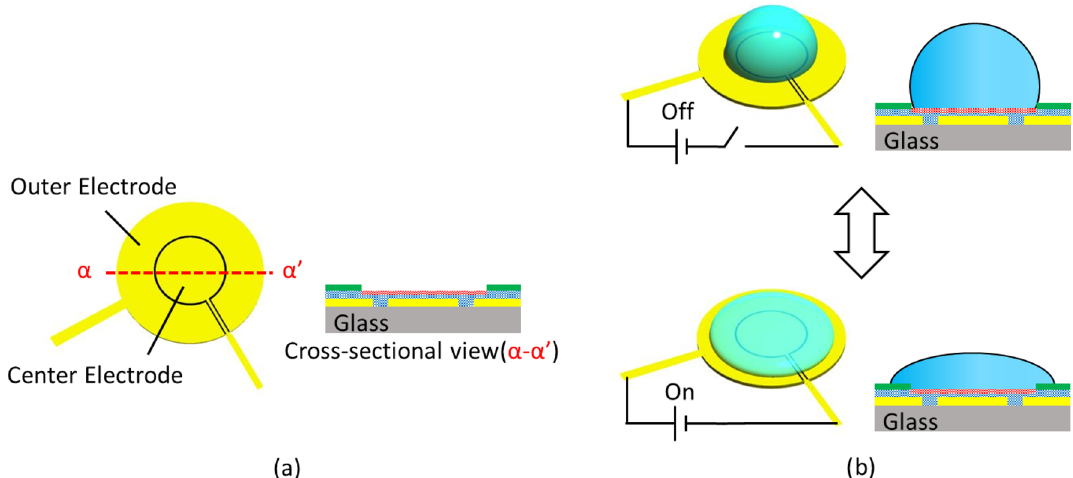
Figure 3. Height control of droplet by EWOD technology. ( a ) Electrode design for EWOD. The center electrode and outer electrode, which are insulated from each other, are designed in a circular pattern for droplet generation. ( b ) An electric field for EWOD is generated by the applied voltage between two electrodes. The contact angle of the droplet decreases with the electric field for EWOD when a voltage is applied. The